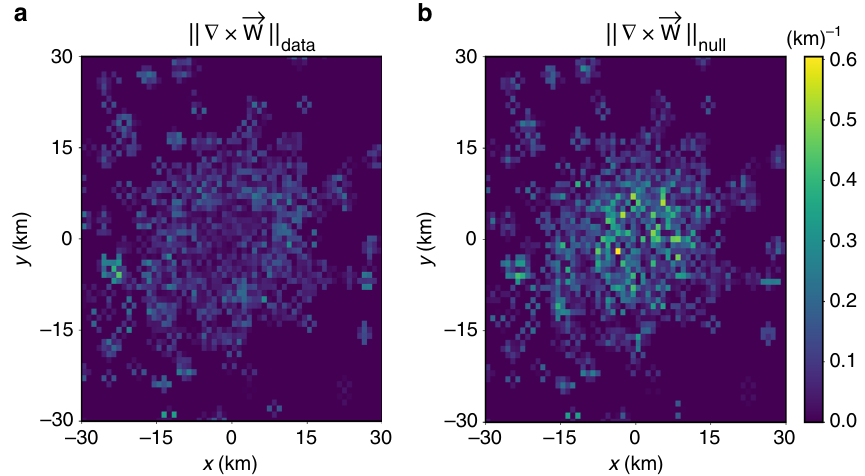
(cid:2) ! . a The curl in London, the colors represent the module of ∇ × W Fig. 3 Curl of W (cid:2) ! randomly reassigning directions to W in each cell. In both cases, the x - and y -axis represent the Easting and Northing of the local Mercator projection in kilometers from Waterloo Bridge